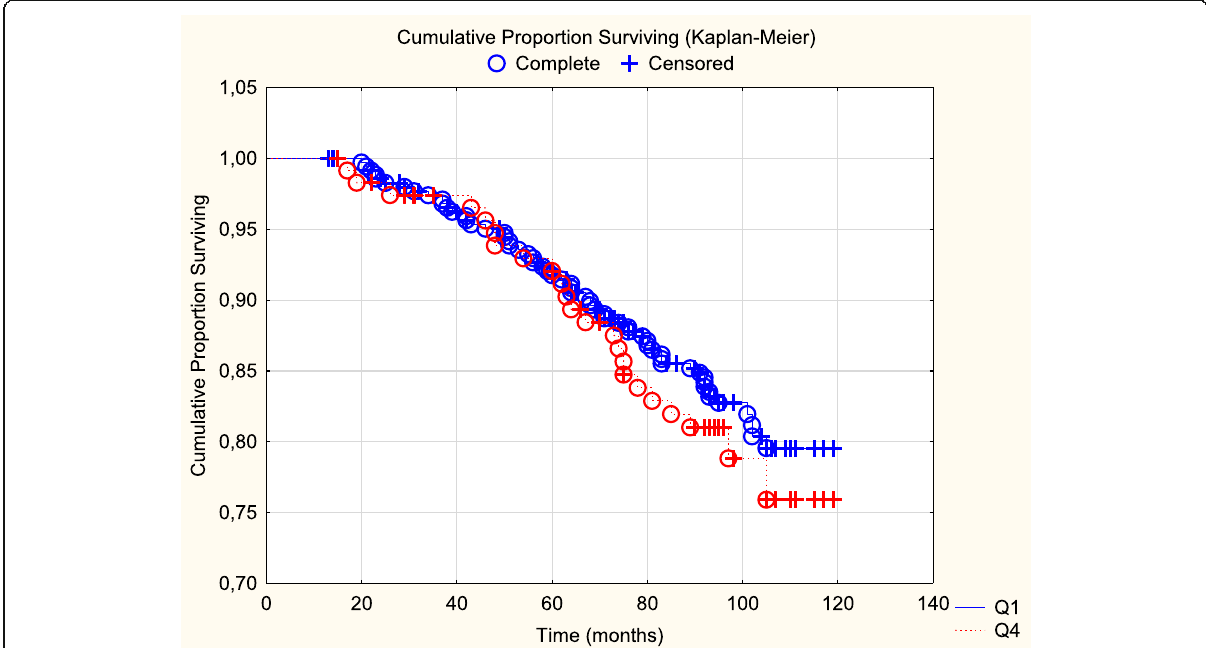
Fig. 1 Cardiovascular mortality in those with the first quartile versus those with the highest quartile of TSP-1 in plasma during a follow-up of 7.9 years. Note: Censored participants were those still living at the end of the study period, or who had died for reasons other than cardiovascular disease. Completed participants were those who had died due to cardiovascular